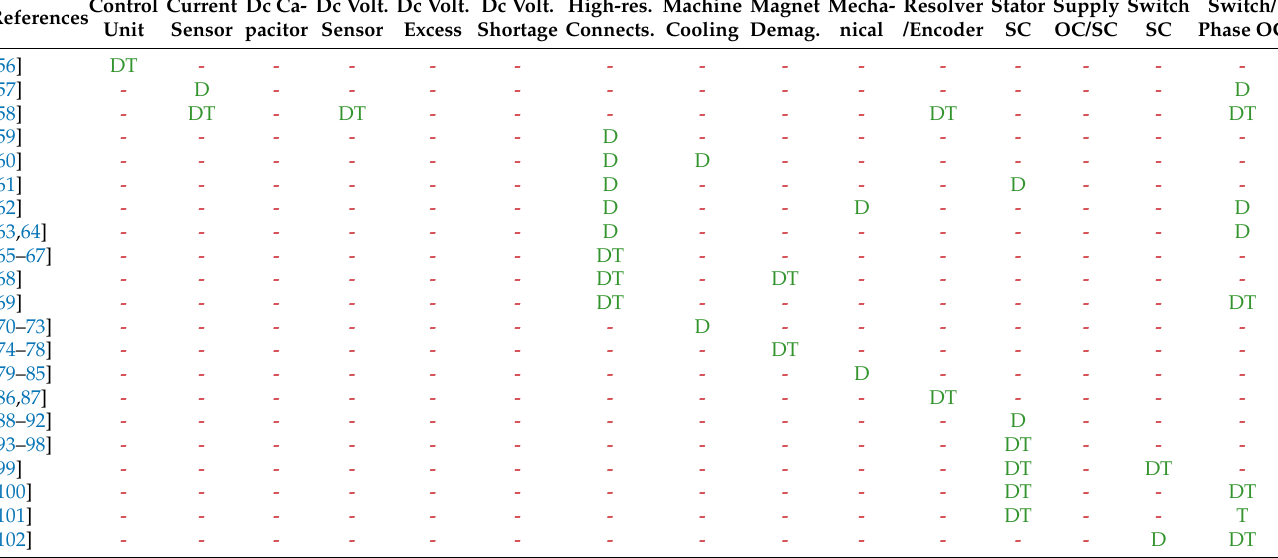
Table 1. Classification of references about fault tolerance in multiphase drives (and paper sections) according to the types of faults detected and tolerated (indicated by D and T, respectively). Survey papers and books are not included in this